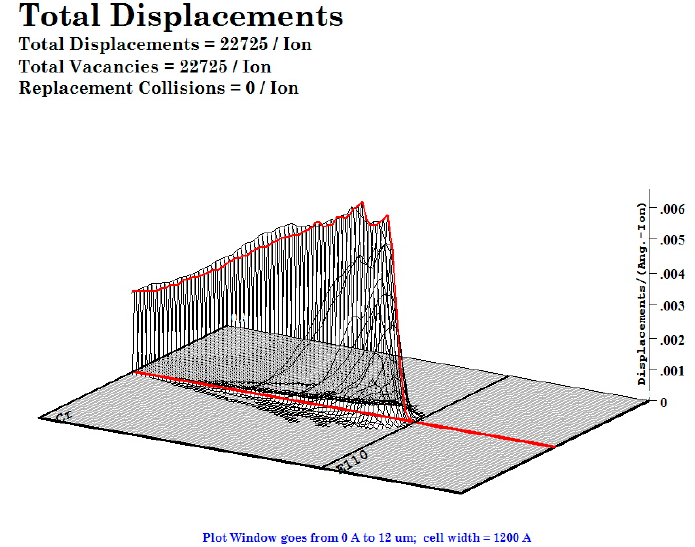
Figure 7. Damage caused by 120 MeV Tc in E110 alloy, coated with 8 µm thin film of Cr.